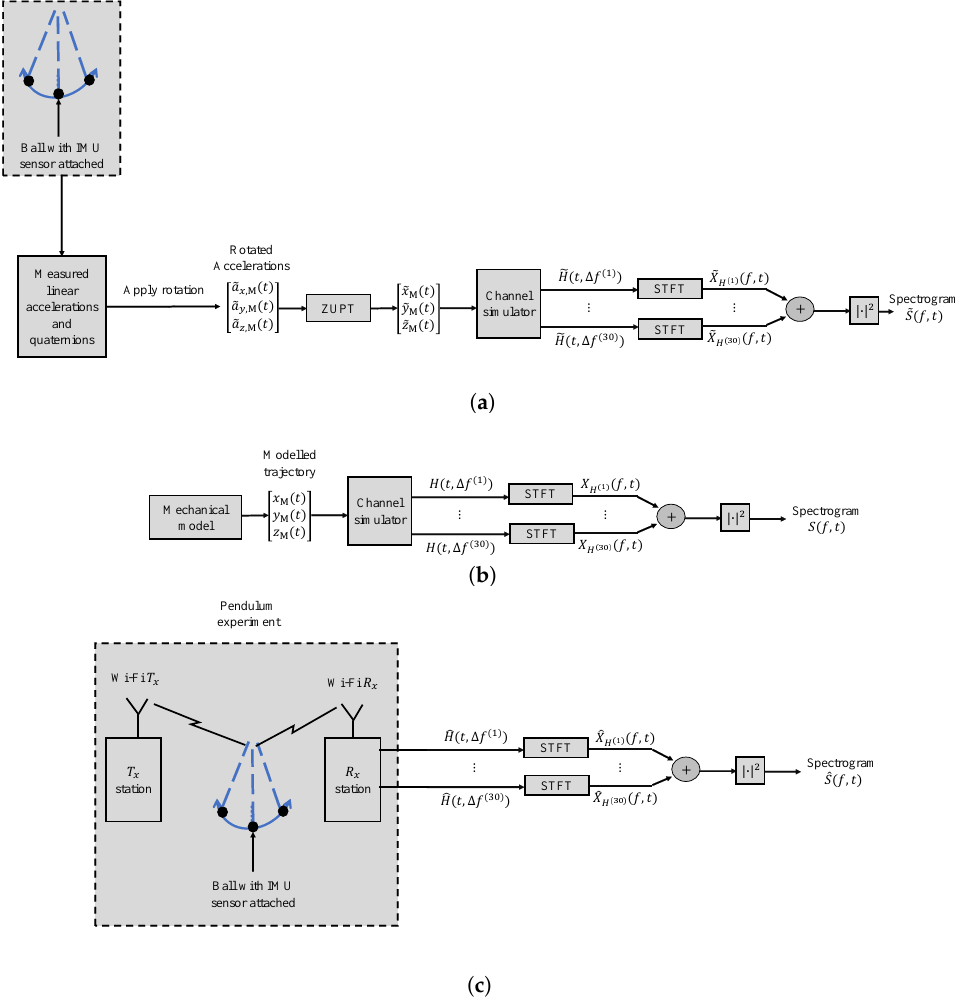
Figure 4. Block diagrams illustrating steps to compute the spectrograms ˜ S ( f , t ) , S ( f , t ) , and ˆ S ( f , t ) of ( a ) the channel model with the IMU data as input, ( b ) the channel model with the trajectories of the mechanical model as inputs, and ( c ) measured CSI data,